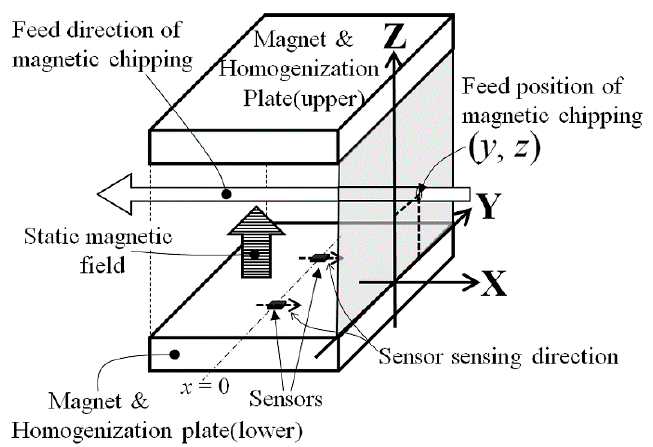
Figure 3. Perspective view of the structure of the position estimation system.